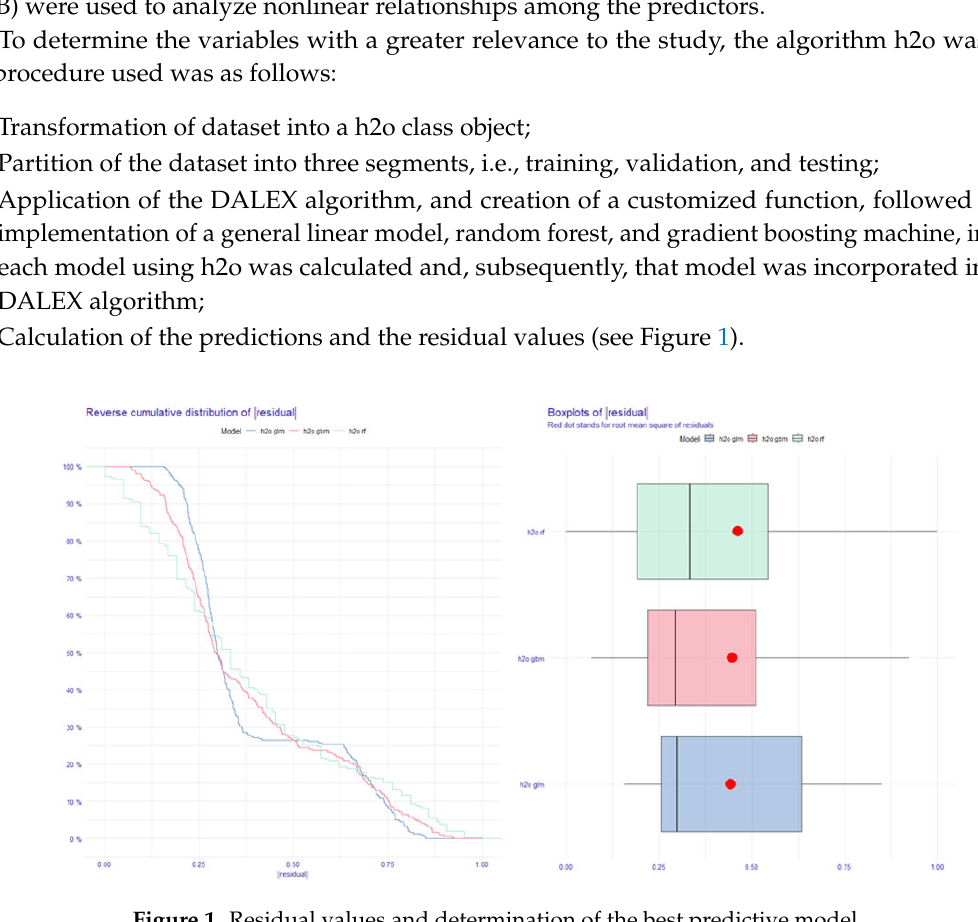
Figure 1. Residual values and determination of the best predictive model.